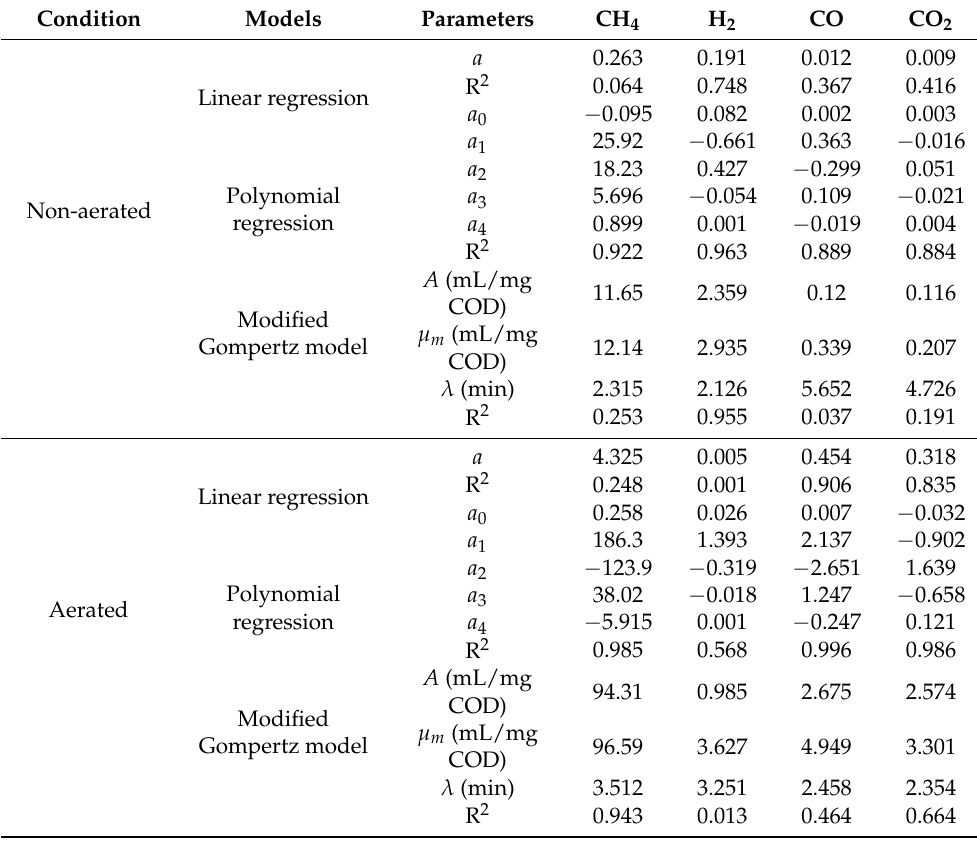
Table 3. Comparison of results between experimental data and Gompertz model for experimental dan simulated data observed non-aerated conditions at 25